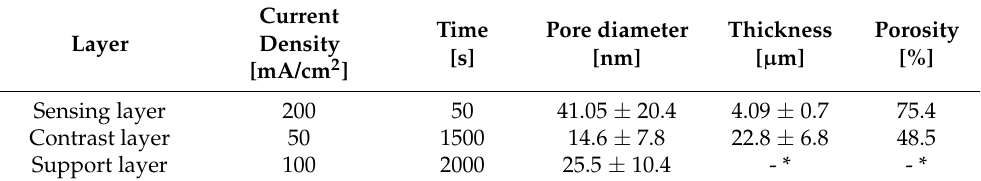
Table 1. Pore diameter, thickness and porosity measured for each of the three layers of the porous silicone membrane (PSiM).